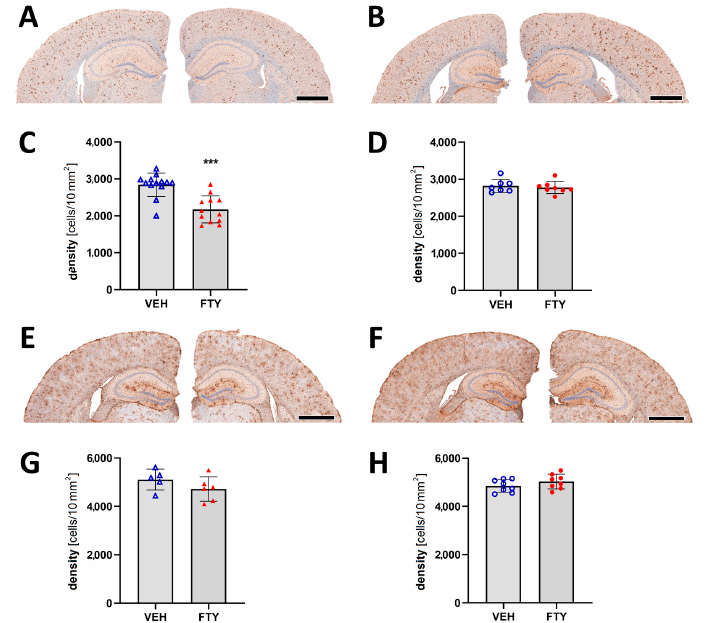
Figure 4. Evaluation of micro- and astrogliosis in mice with late treatment paradigm (at 175 days of age). ( A , B ) Representative images of Iba1 immunostaining of male ( A ) and female ( B ) mice. Microglia activation was determined as density of IBA1-positive cells in males ( C ) and females ( D ). ( E , F ) Representative images of GFAP immunostaining in males ( E ) and females ( F ). Astrocyte density in males ( G ) and females ( H ). Data are presented as mean ± SD; VEH males n = 13 for IBA1, n = 5 for GFAP, FTY males n = 12 for IBA1, n = 6 for GFAP, females n = 8. Significance was calculated using Student’s t -test, and it is given as ***: p ≤ 0.001. Scale bars: 1 mm.